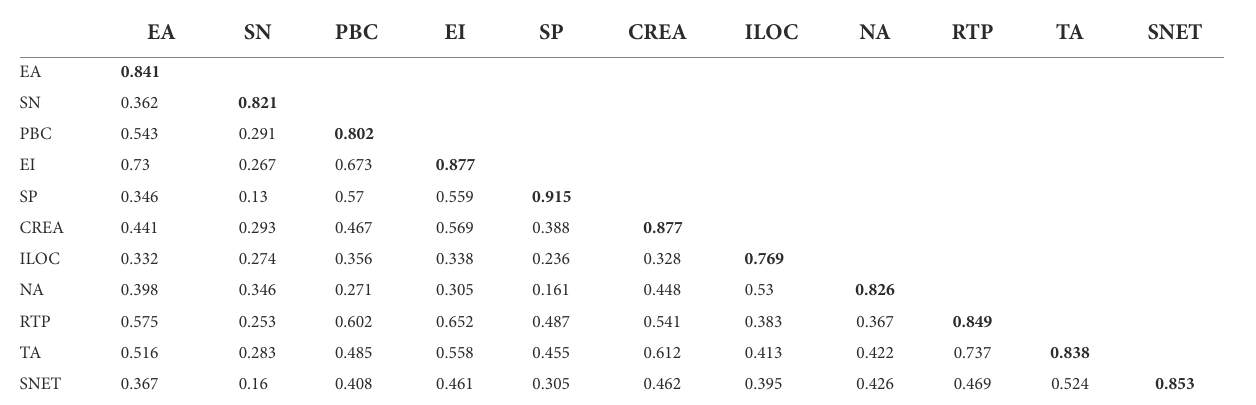
TABLE 6 Fornell–Lacker criterion.